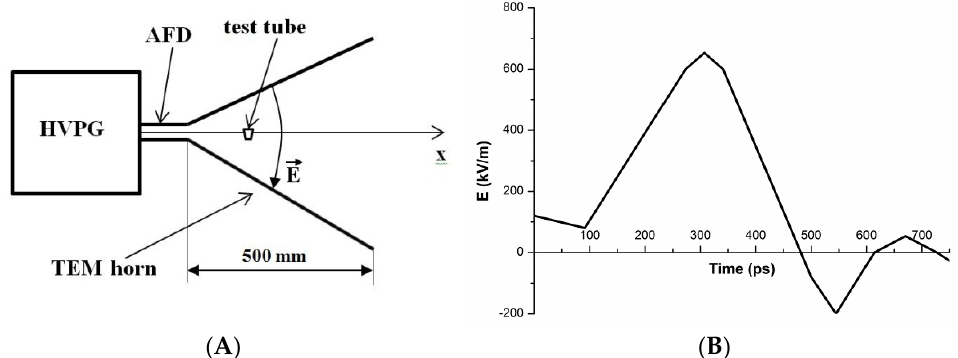
Figure 1. Schematic representation of the working area of the PEMF experimental setup ( A ); and oscillogram of the ultra-short electromagnetic pulses recorded within the antenna mouth in the point, where the test tube with the PEMF-irradiated solution was placed ( B ). In A, the thin-end arrows indicate the main units of the experimental setup: the HVPG (high-voltage pulse generator), the AFD (antenna-feeder device), the test tube containing the sample to be irradiated, and the TEM horn antenna. → E is the direction of the electric field strength vector, indicated by the thick-end arrow. The length of the TEM horn antenna is 500 mm.